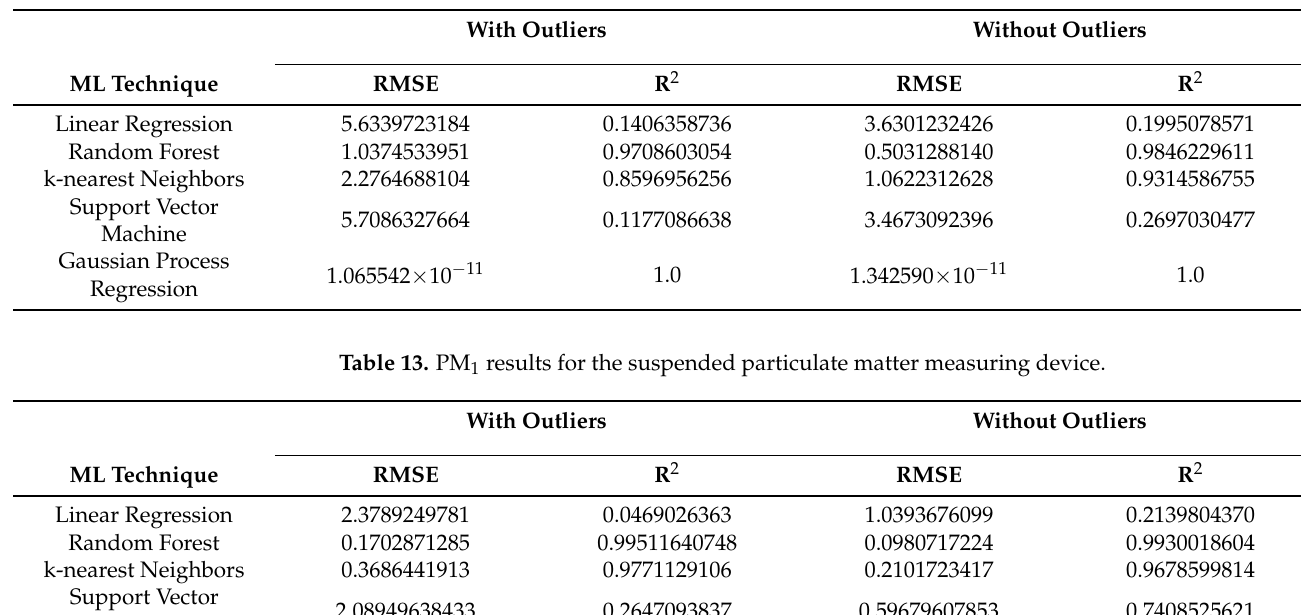
Table 12. PM 2.5 results for the suspended particulate matter measuring device.